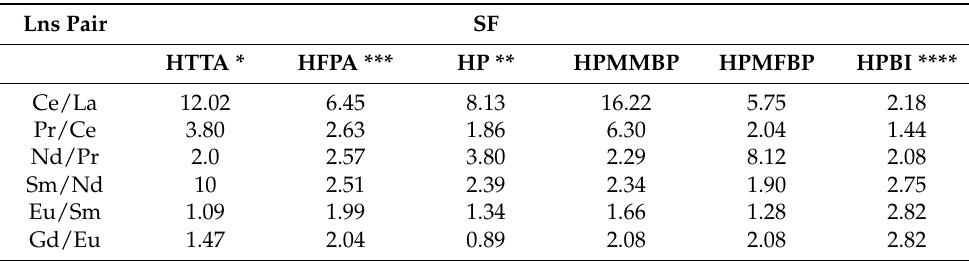
Table 3. Values of the separation factors of the light lanthanoid pairs obtained using chelating extractants alone in C 6 H 6 .